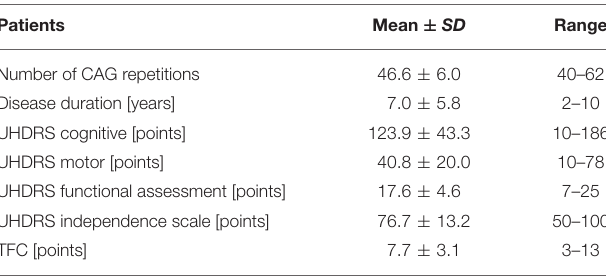
TABLE 1 | Neurological characteristics of the study